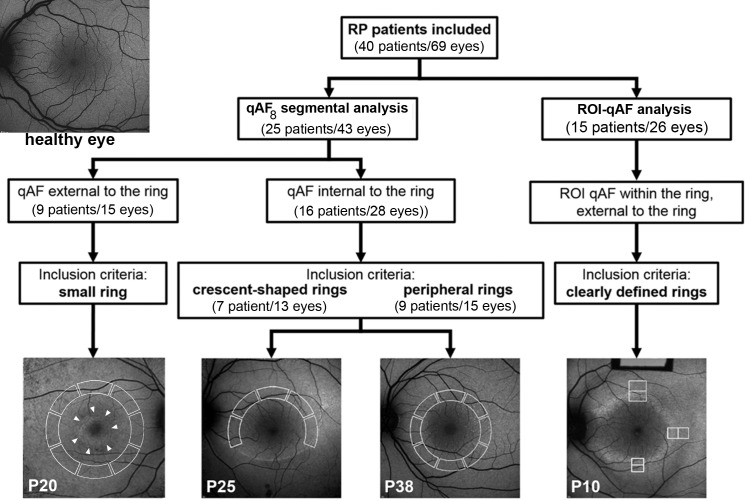
Assignment of RP patients for qAF analysis. Quantitative fundus autofluorescence external and internal to the ring was measured within circularly arranged segments (white solid lines in images) (segmental qAF8 analysis) in patients with RP characterized by small, crescent-shaped and large peripheral SW-AF rings. In the case of crescent-shaped rings, internal to the ring refers to normal-appearing retina. Region of interest-qAF (ROI-qAF) analysis included RP patients with perifoveal circular or oval SW-AF rings. Region of interest-qAF was measured using rectangular areas (white lines in images) located within the inner and outer borders of the ring and just external to the ring. The image, top left, is of a healthy eye, age 19. P, patient number.